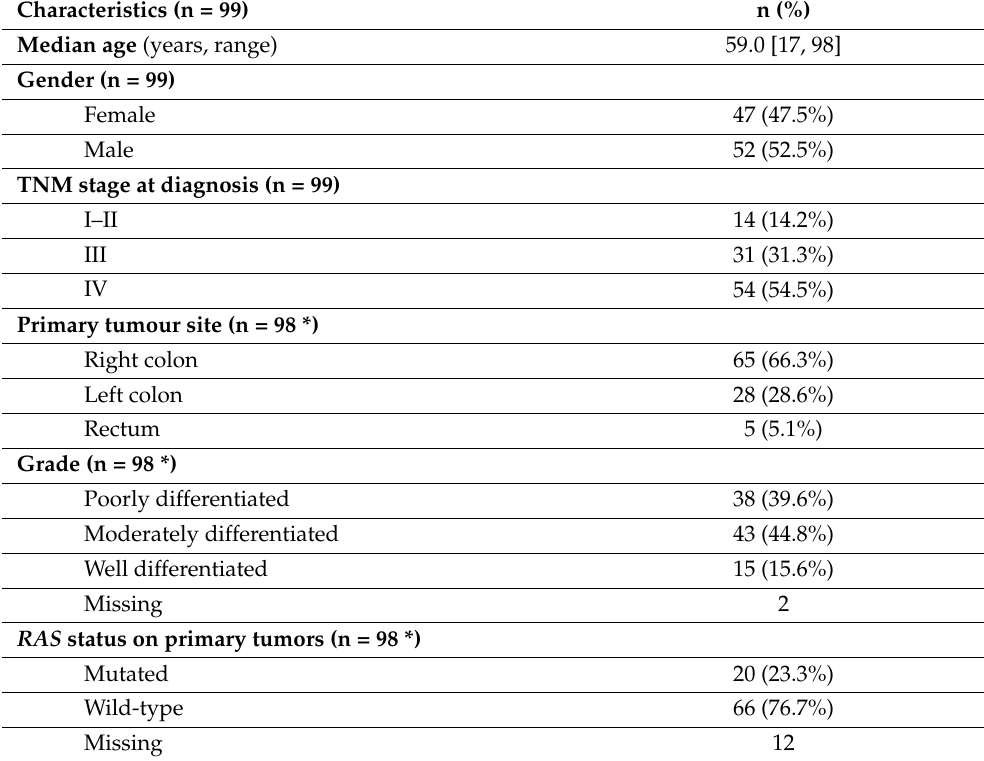
Table 1. Patient and tumor